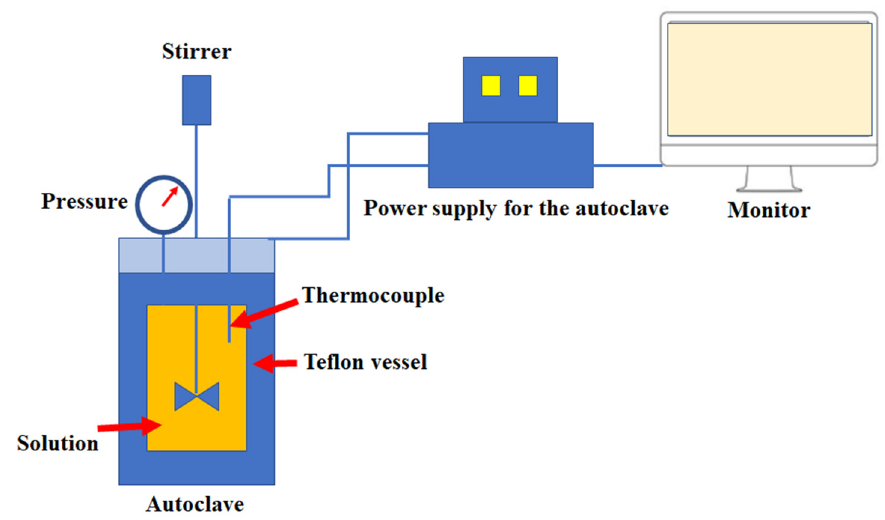
Figure 2. Autoclave system diagram.